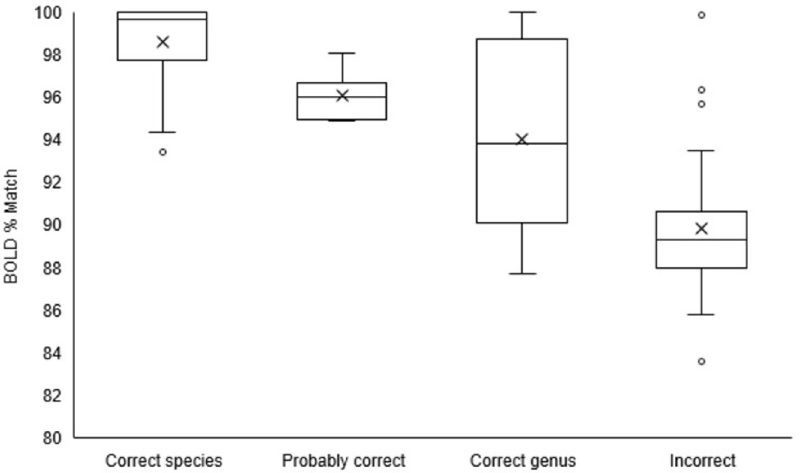
Fig 5. Boxplot of Scarabaeinae case of study showing the range of BOLD percentage matches for the categories: Correctly Identified species, probable correctly identified species, correctly identified genus, and incorrect identification. The median is represented by a line, the mean is represented by an X markers and outliers are the white dots.